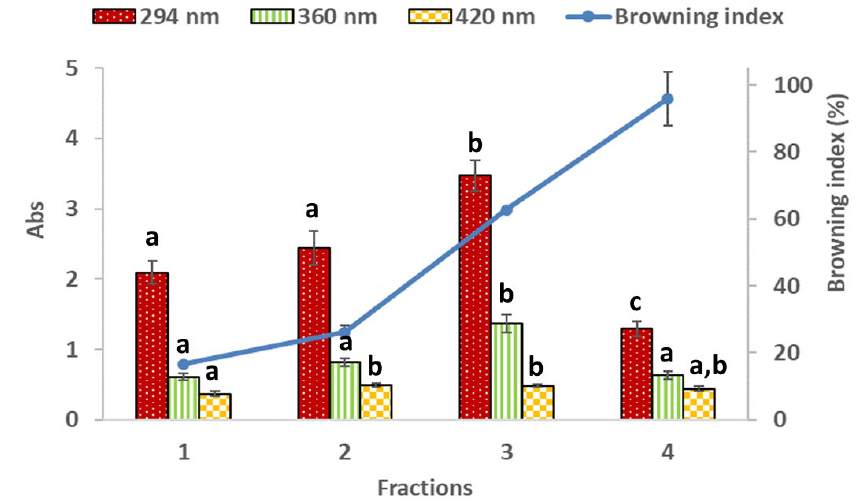
Figure 2. Maillard reaction products and browning index for Eisenia bicyclis (Kjellman) Setchell. Results are expressed as mean ± SD of three experiments ( n = 3). For each wavelength, different superscript letters mean statistically significant differences ( p < 0.05).